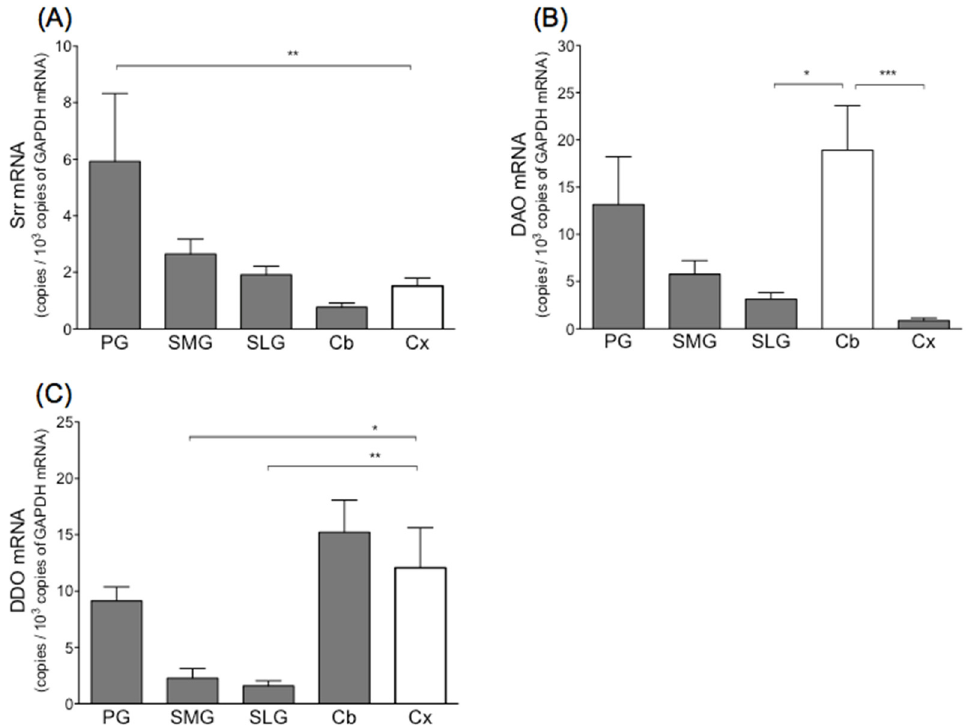
Figure 1. mRNA levels of serine racemase (Srr) ( A ), D -amino acid oxidase (DAO) ( B ) and D -aspartate oxidase (DDO) ( C ) in three salivary glands and two brain areas (cerebral cortex and cerebellum) in rat. Values represent mean ± SD in 6 rats. Significantly different from cerebral cortex (Srr, DDO) or cerebellum (DAO) according to Dunn’s post hoc test following Kruskal–Wallis test; * p < 0.05, ** p < 0.01, and *** p < 0.001. PG, parotid gland; SMG, submandibular gland; SLG, sublingual gland; Cb, cerebellum; Cx, cerebral